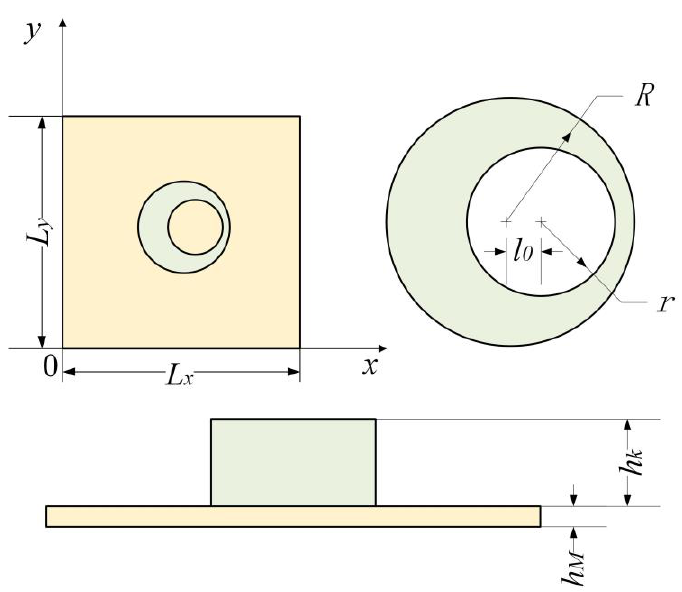
Figure 1. Definitions for the configuration of the MAM loaded with an asymmetric